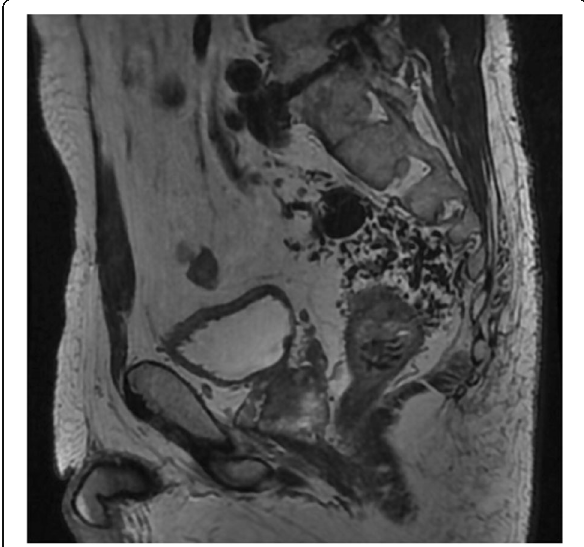
Fig. 4 Abdominal enhanced magnetic resonance imaging revealed blood inflow from branches of the median sacral artery to APFs by flow void at the pelvic surface of the